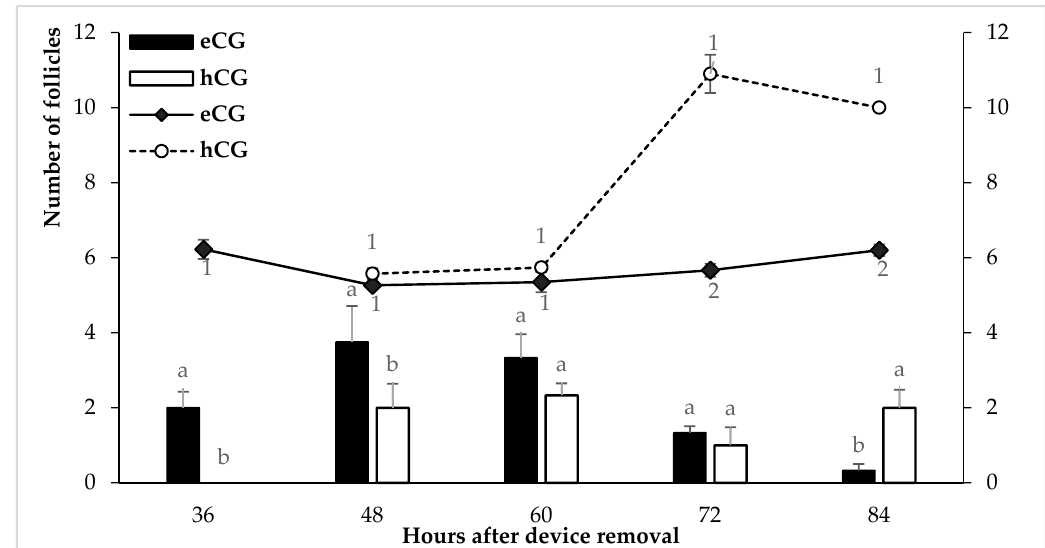
Figure 2. Mean diameter of the largest follicle (lines) and number of follicles ≥ 4 mm (bars) observed by transrectal ultrasonography after CIDR removal in Dorper sheep treated with 300 IU of eCG or hCG during seasonal anestrous. a,b Different superscripts indicate significant differences in bars ( p < 0.05); 1, 2 Different numbers indicate significant differences in lines ( p < 0.05).